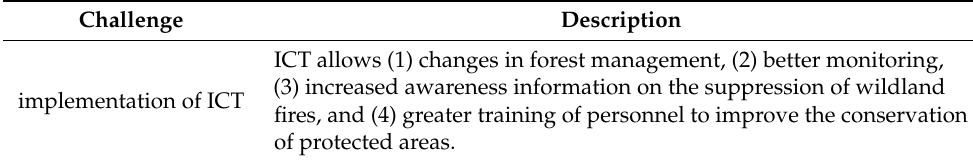
Table 3. Challenges for DSS in wildland fires in the Black Sea according Zaimes [35].